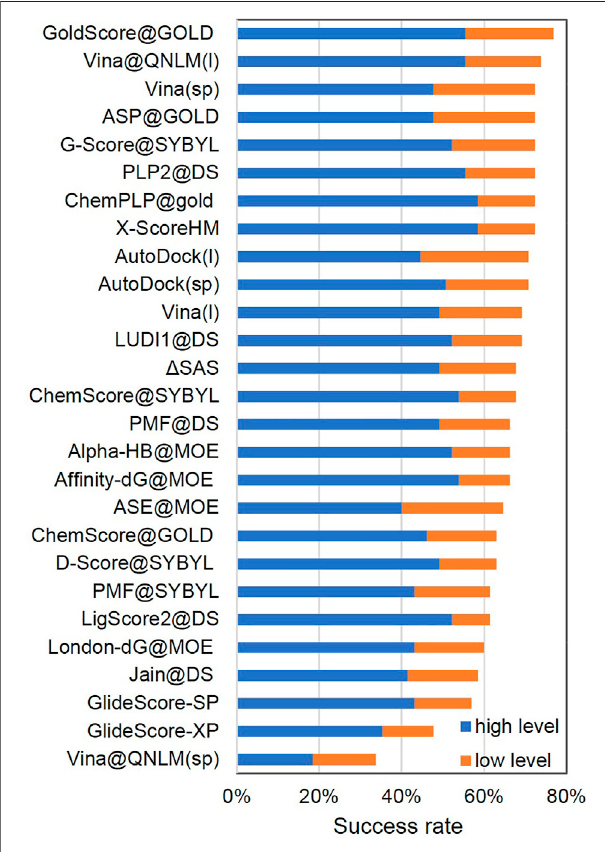
FIGURE 2 | Scoring power of crystal structures and optimized structures and Pearson correlation coef fi cients of Vina@QNLM in single-point (sp) and local (l) modes (blue and orange bars), compared to the methods evaluated in CASF-2013 and recalculated.